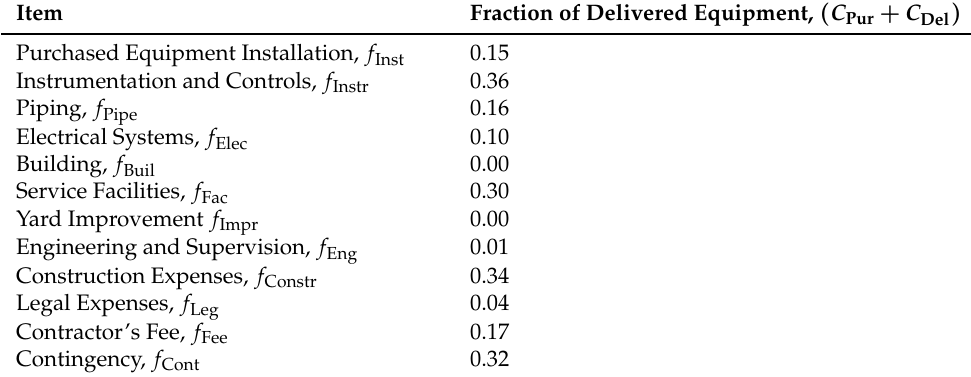
Table 2. Capital cost